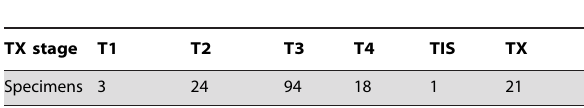
Table 4. A description of tumor specimens by stage for discovery